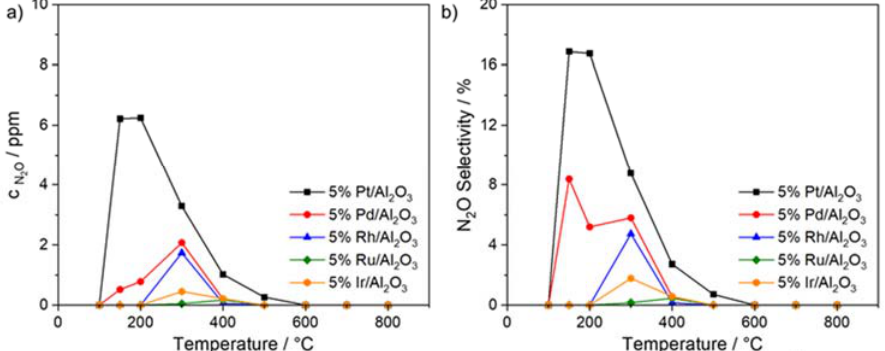
Figure 4. ( a ) N 2 O concentration and ( b ) N 2 O selectivities over reaction temperature for different noble metal catalysts, WHSV = 600 L/g